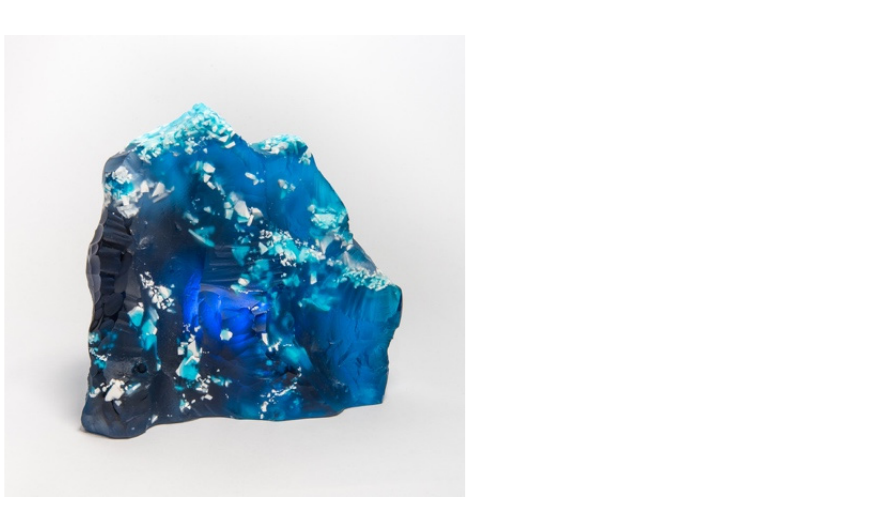
Figure 22. Kelly, Glacial Mind Landscape , 2019; turquoise kiln cast glass sculpture with compatible pre-fired bone china aggregate inclusions; photo credit: Marzena Ostromecka, used with permis- sion.